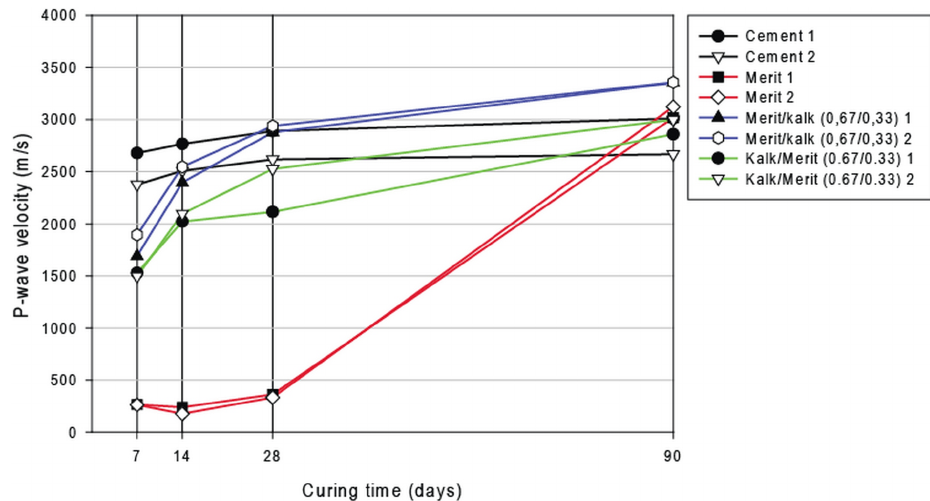
Figure 7. P-wave velocity as a function of curing time for individual and blended binary binders. Correspondingly, adding slag (GGBFS) and bio fly ash (combination CE) leads to the increase of bonding soil particles, which is also important in providing higher particle friction and better packing. As a result, soil strength increases which is reflected in the higher speed of the elastic waves (P-wave coefficient = 2453.1). The measurements were done by T = 47 ◦ C for all the data in Table 1. Depending on the amount of added slag (type Merit 5000) and Portland cement, bonding soil particles generally increases the UCS values compared to the one in the fly ashes, which demonstrated poor or low effects. The improvement is introduced by glueing of soil particles with cementitious binder at the points of contact by stabilising agents. Table 1. The effects from various binders on soil stabilisation on day 7th of curing time, measured by P-wave